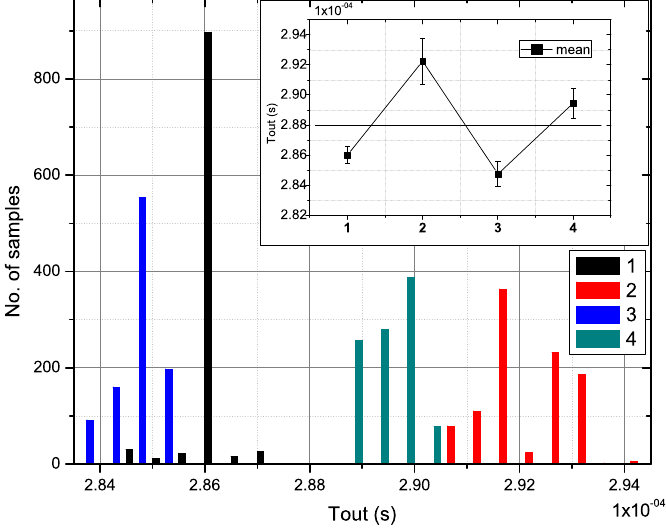
Figure 14. Histogram from the opamp variations with four different encapsulated. R S = 2.7 K Ω